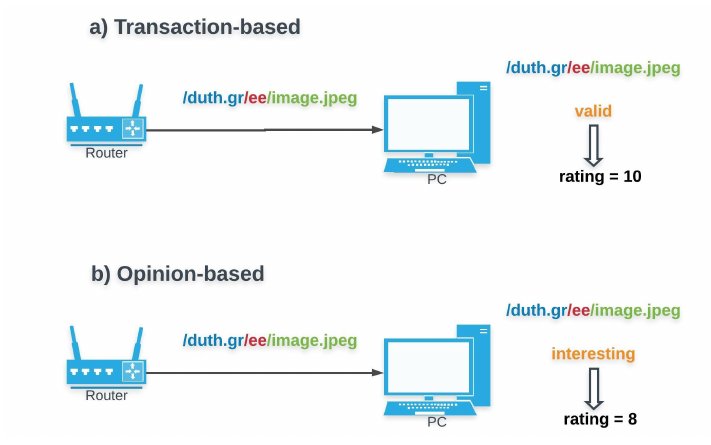
Figure 3. ( a ) Transaction-based vs ( b )